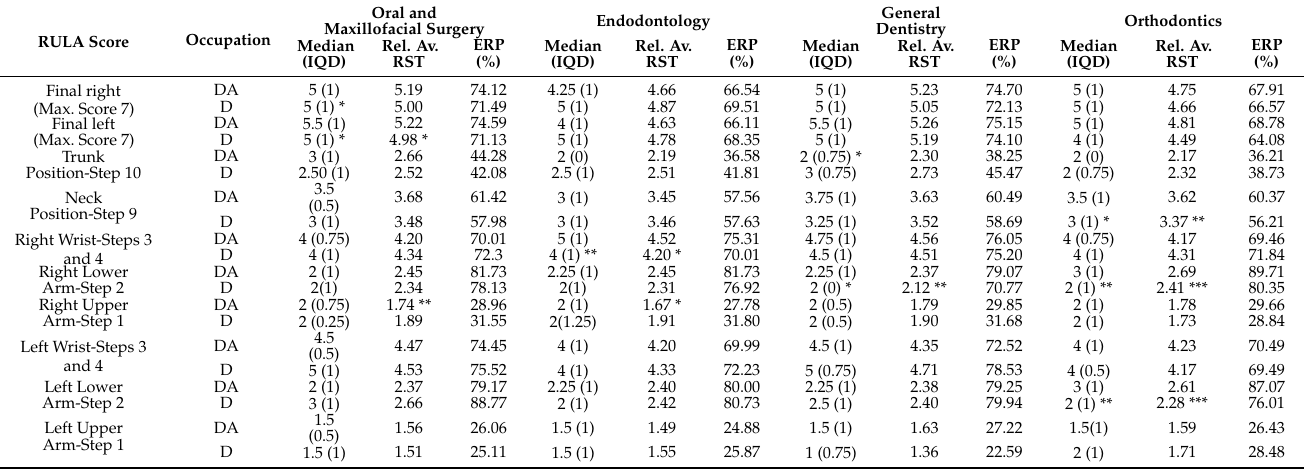
Table 3. RULA scores for dentists and dental assistants of oral and maxillofacial surgery, endodon- tology, general dentistry, and orthodontics. Significant differences between dental assistants and dentists are indicated in asterisks, whereby the significant lower ergonomic risk score is marked. In addition, asterisks indicate the magnitude of the statistical significance (* p < 0.05; ** p < 0.01; *** p <